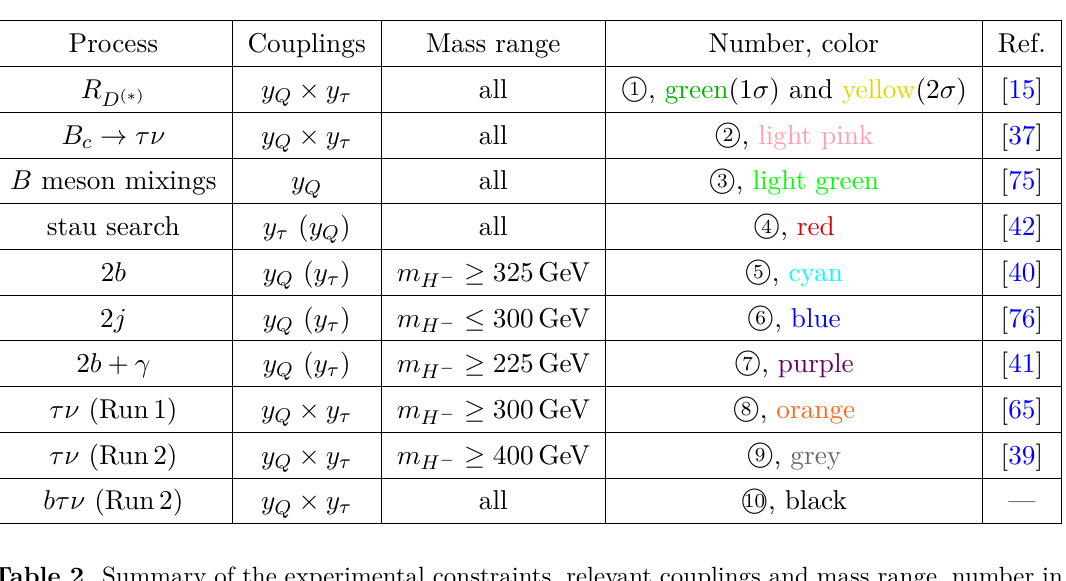
Table 2 . Summary of the experimental constraints, relevant couplings and mass range, number in the figure and corresponding color. The current LHC bound is expressed by solid lines, and future prospects with 139 fb − 1 , 500 fb − 1 and 3 ab − 1 of data are shown in dashed, dotted-dashed, dotted lines in the same color. We newly added the prospect of our bτν signature with 139 fb − 1 of